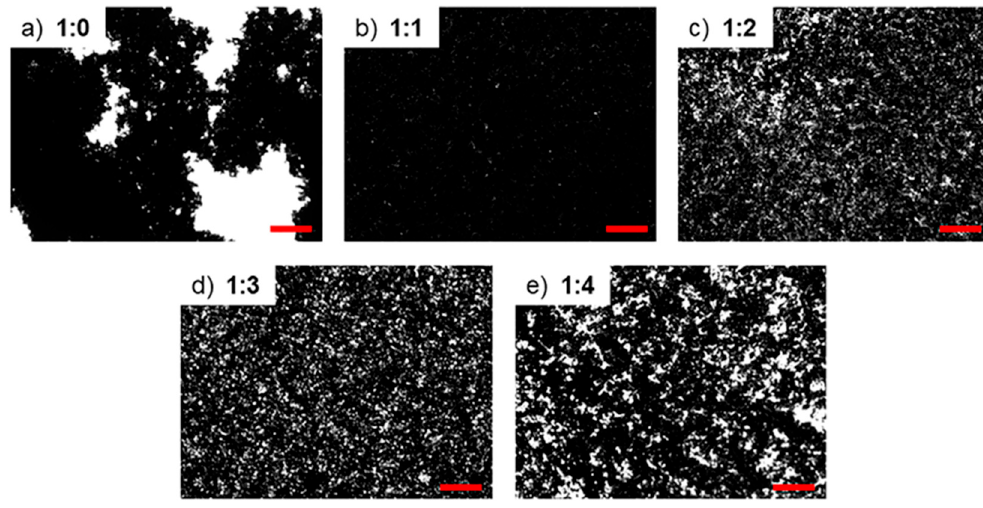
Figure 1. Optical images of aqueous dispersions with different graphene nanoplatelets (GNP):DNA ratios (w/w): ( a ) 1:0; ( b ) 1:1; ( c ) 1:2; ( d ) 1:3; ( e ) 1:4. Scale bar: 300 μ m.